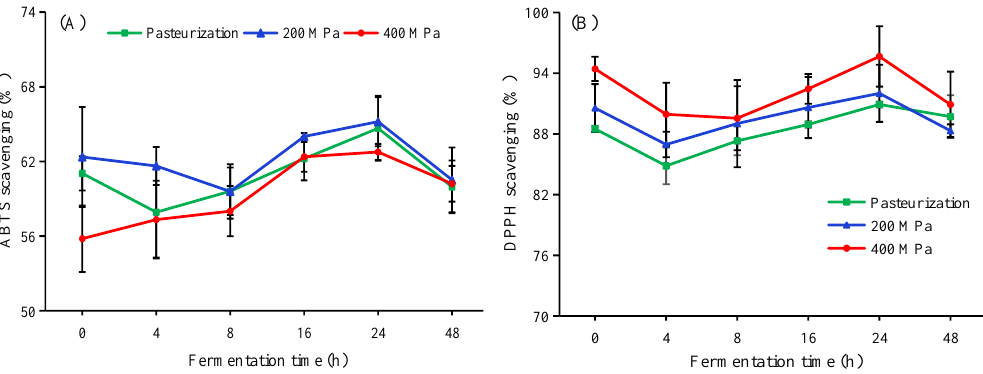
Figure 4. ABTS scavenging ability ( A ) and DPPH scavenging ability ( B ) of different treated apple juice during fermentation. HHP treatments (200 or 400 MPa, 10 min); Pasteurization (85 °C, 15 min). Experiments were performed in triplicate; vertical bars indicate ± SD ( p < 0.05).